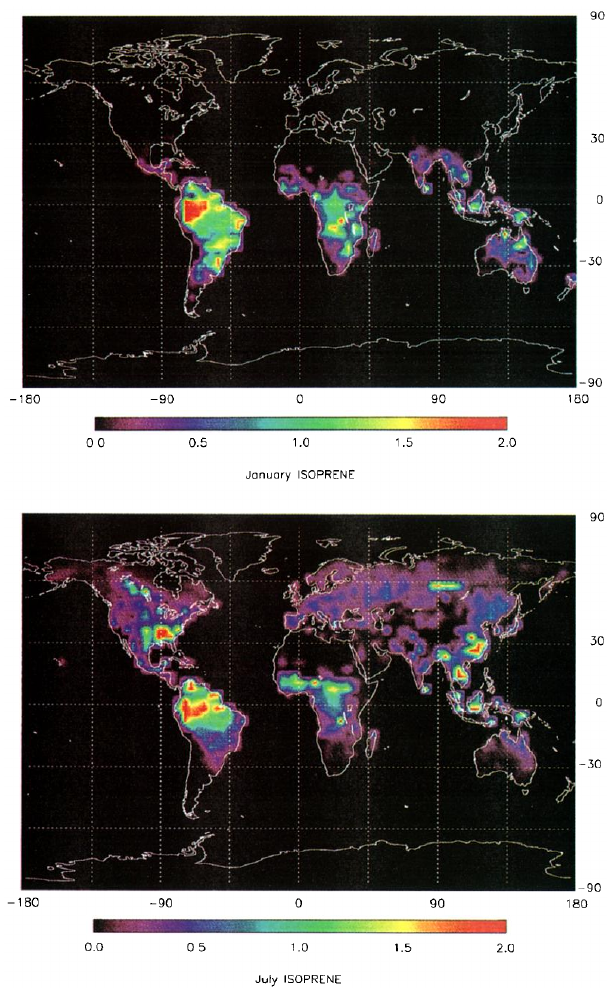
Figure 14. Global distribution of isoprene emission rate estimates (g Cm − 2 month − 1 ) for (top) January and (bottom) July (from Guenther et al.,